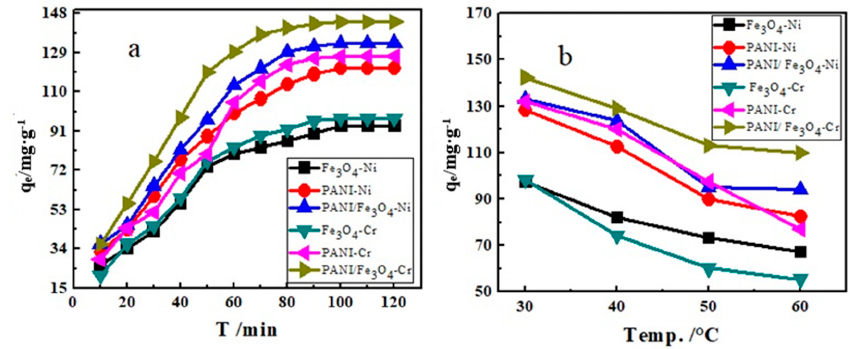
Figure 7. Effect of ( a ) contact time and ( b ) temperature on removal of Cr(VI) and Ni(II) ions through Fe 3 O 4 , PANI, and PANI/ Fe 3 O 4 composites.